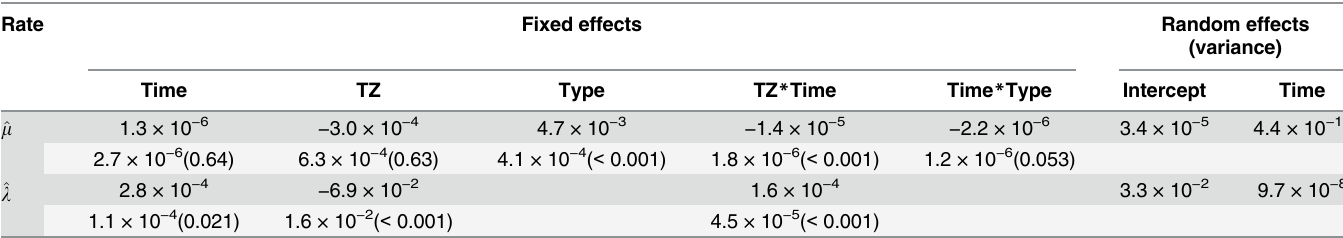
Table 1. Linear mixed effect models were fit to μ and λ estimates using backward stepwise variable selection, with random intercept and slope terms due to the variance between individual axons. The table shows the coefficient, the standard error and the p-value, with degrees of freedom esti- mated by Satterthwaite approximations. ^ m does change between control and TTX axons, while ^ l does not. Both ^ l and ^ m have a strong interaction between time and whether the axon has reached the TZ or not. Models were only fi t to time points when there were at least two TTX and two control axons (-13 hours to +13 hours). Marginal R 2 for ^ m is 0.11 (considering fi xed effects only), conditional R 2 is 0.48 (including random effects). Marginal R 2 for ^ l is 0.27, conditional R 2 is